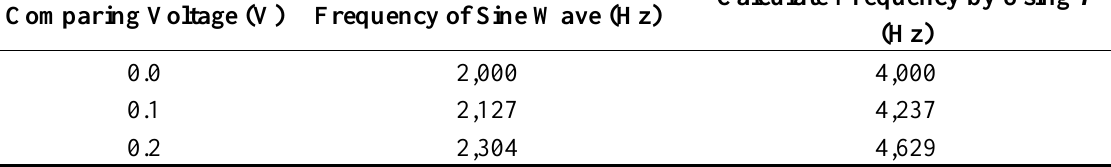
Table 1. The calculation frequency of sine wave by using the length of a single rising edge. Comparing Voltage (V)